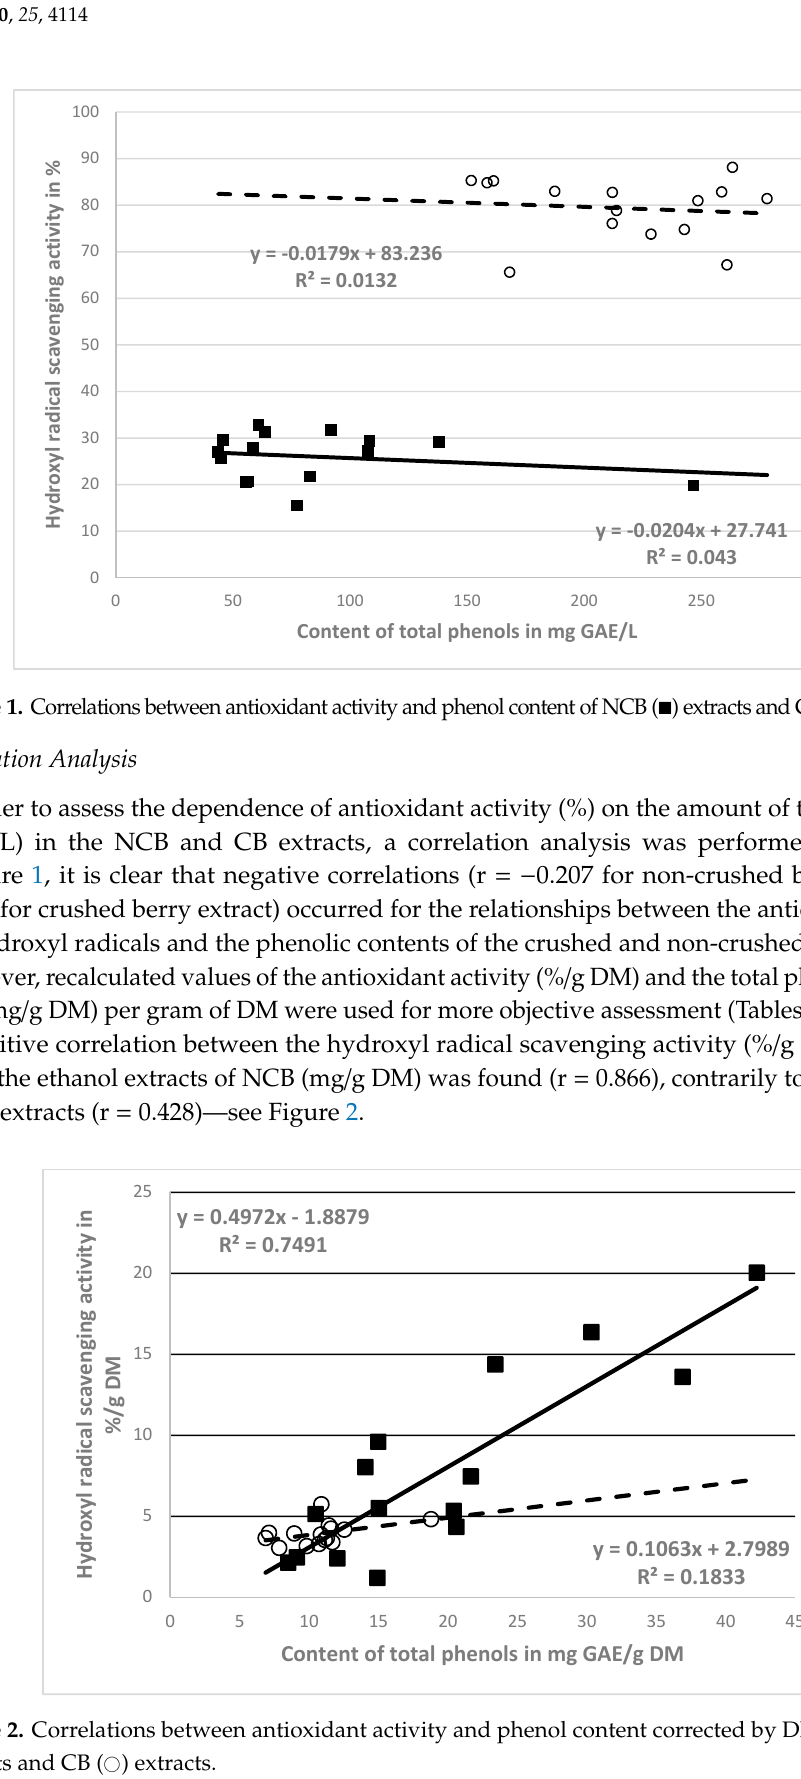
Figure 2. Correlations between antioxidant activity and phenol content corrected by DM of NCB ( ■ ) extracts and CB ( ○ ) extracts.